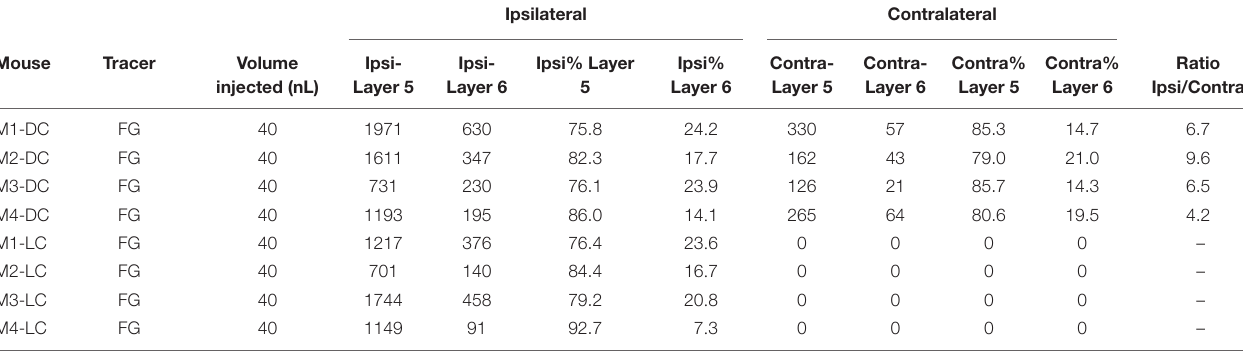
Contra, contralateral; Ipsi, ipsilateral; FG, Fluorogold. TABLE 2 | All animals used for bilateral injections in this study, with numbers of cells counted per